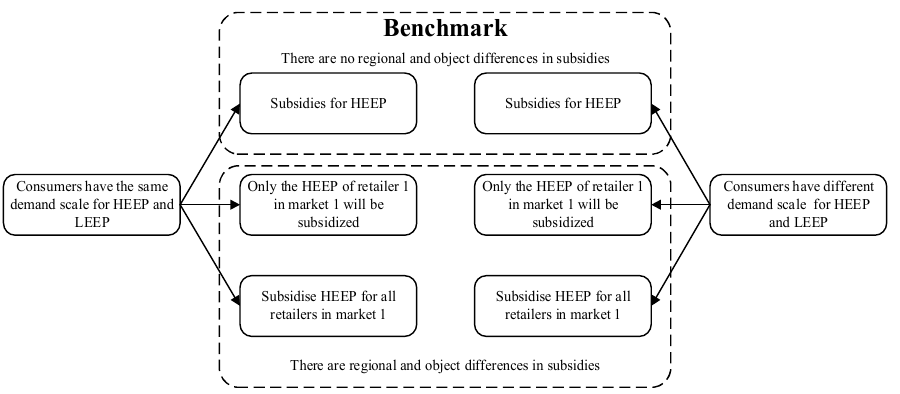
Figure 3. Frame diagram of the numerical example.